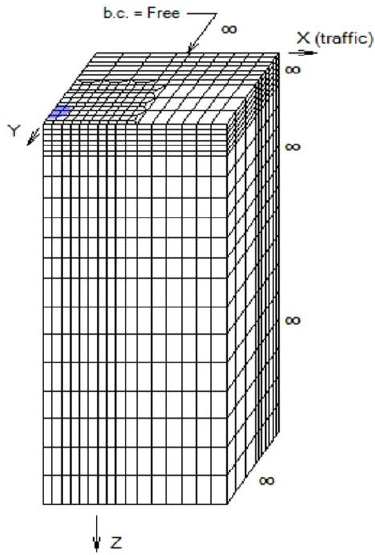
Figure 4. Boundary conditions and meshing of flexible pavement structure. Localized meshing was applied around the loaded area with 17,423 nodes and 3800 finite elements. The free boundary condition was chosen for the Y boundary of Layer 1 away from wheel. For both x and y directions, nine elements were chosen for refined region, whereas six elements were selected for the coarse region [30]. The lengths along the x and y directions in the refined region were 400 and 550 mm, respectively. Symmetric meshes with solid quadratic elements comprising 20 nodes were adopted to account for computational time and accuracy [30]. IRC: 37-2018 specifies a minimum subgrade CBR of 5%; the CBR of untreated kaolin clay was found to be 1.39%. The contact pressure, Poisson’s ratio, and resilient modulus of bitumen binder were adopted as specified in IRC: 37-2018. The equivalent modulus of the granular and subgrade layers was adopted based on IRC: 37-2018 [14]. The outputs of the 3D FEA were compressive strains and tensile strains at the subgrade and bituminous surface,